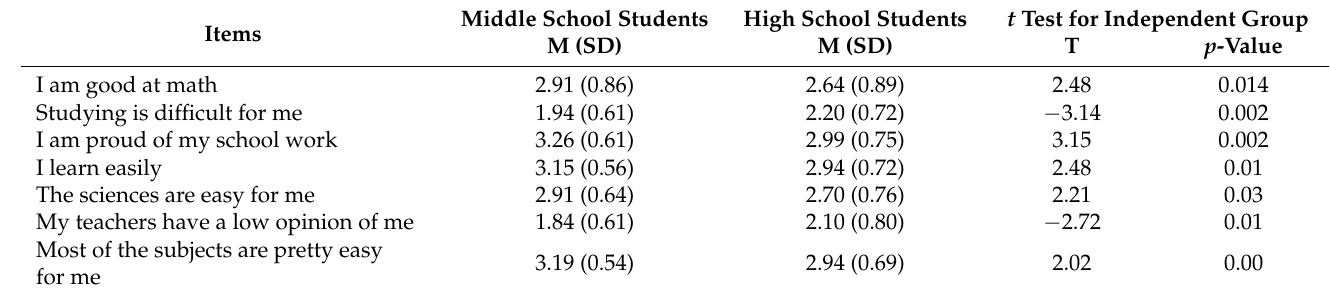
Table 4. The Independent Samples t Test: significant items of School Success